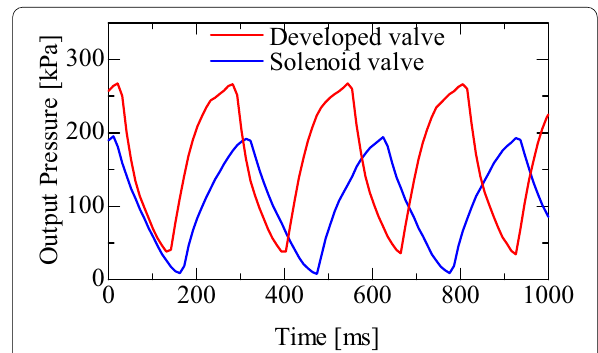
Fig. 14 Comparison of the developed device and the solenoid valve